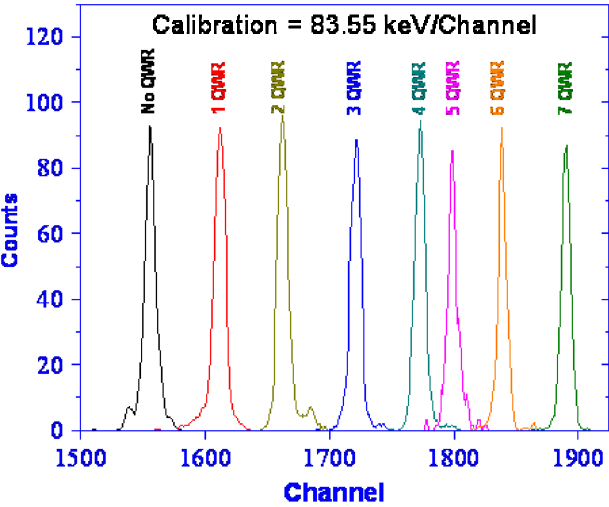
location.FIG. 16. (Color) Energy gain after each